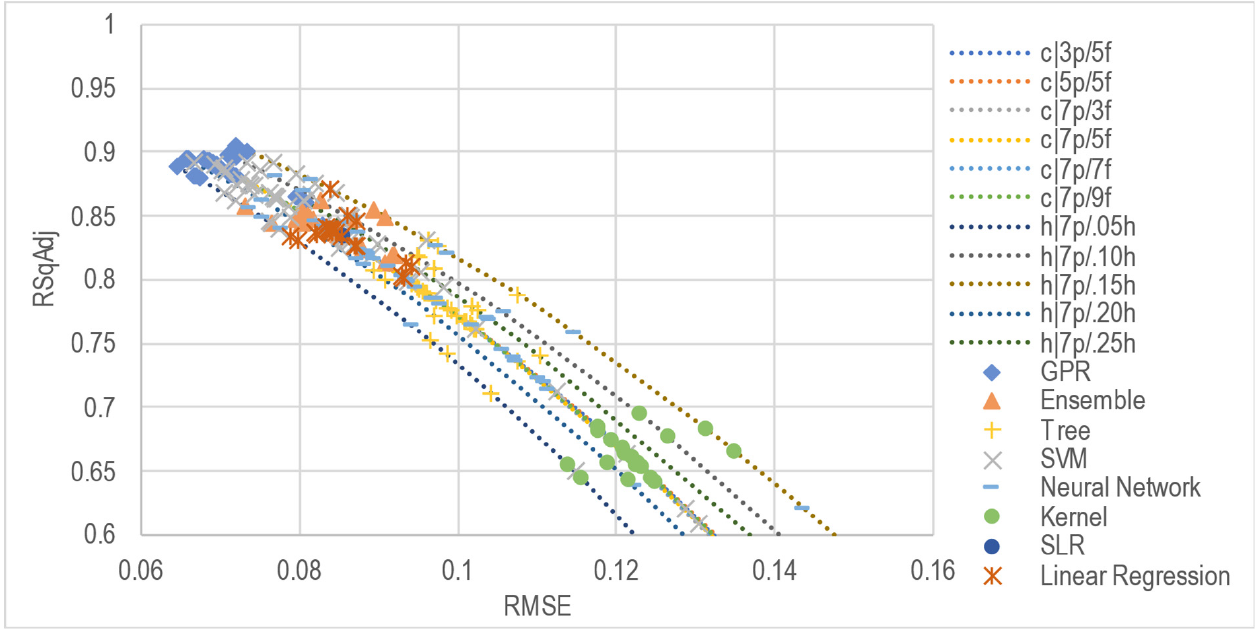
Figure 4. Nonparametric tested models, validations, and predictors with best RMSE and RSqAdj results.